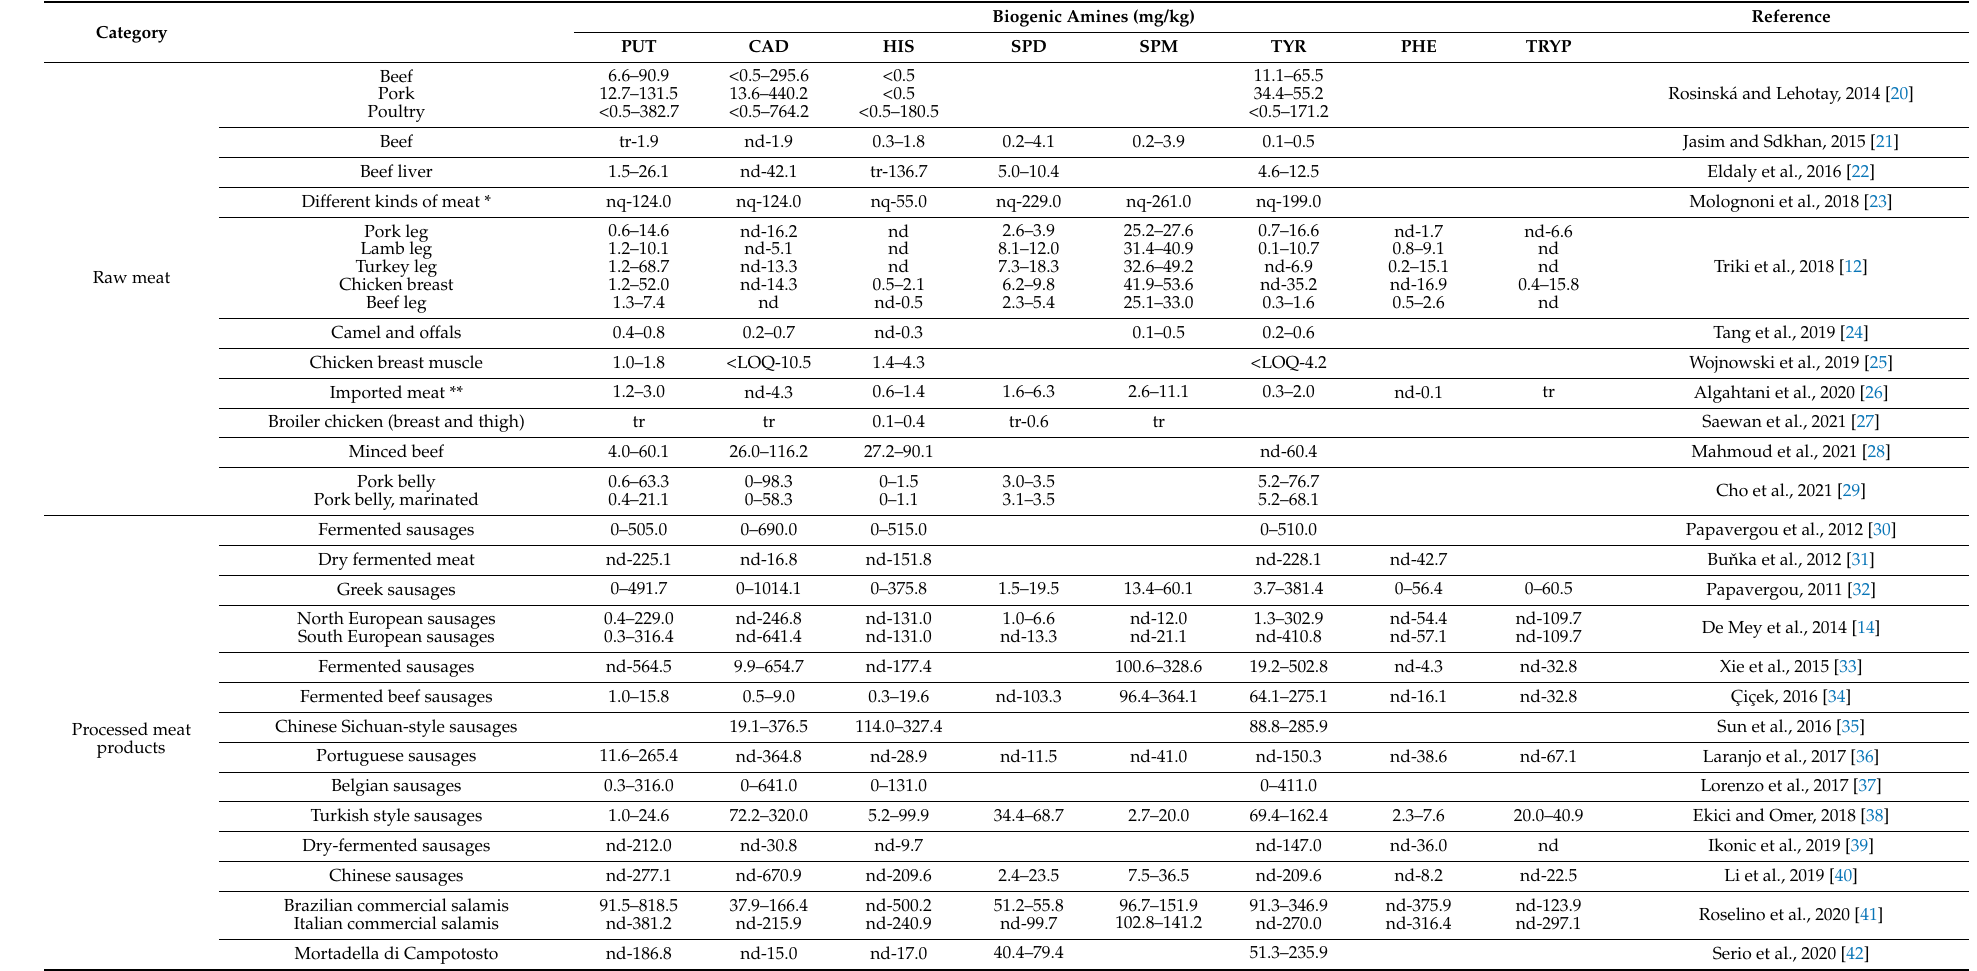
Table 1. Biogenic amines levels in different meat and meat products reported in some studies from the